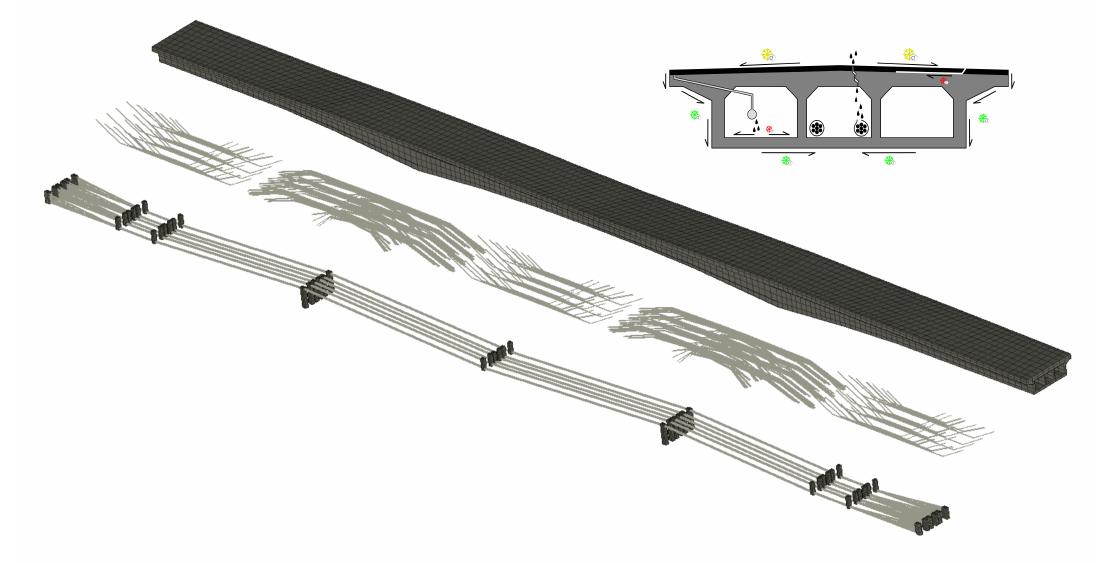
Figure 3. Model of the Wonka bridge during pre-processing showing the FEM mesh, pre-stressing cables in the webs of the girder, and the unbonded pre-stressing cables with the deviators. The cross-section view schematically shows the application of the chloride ingress boundary condition.